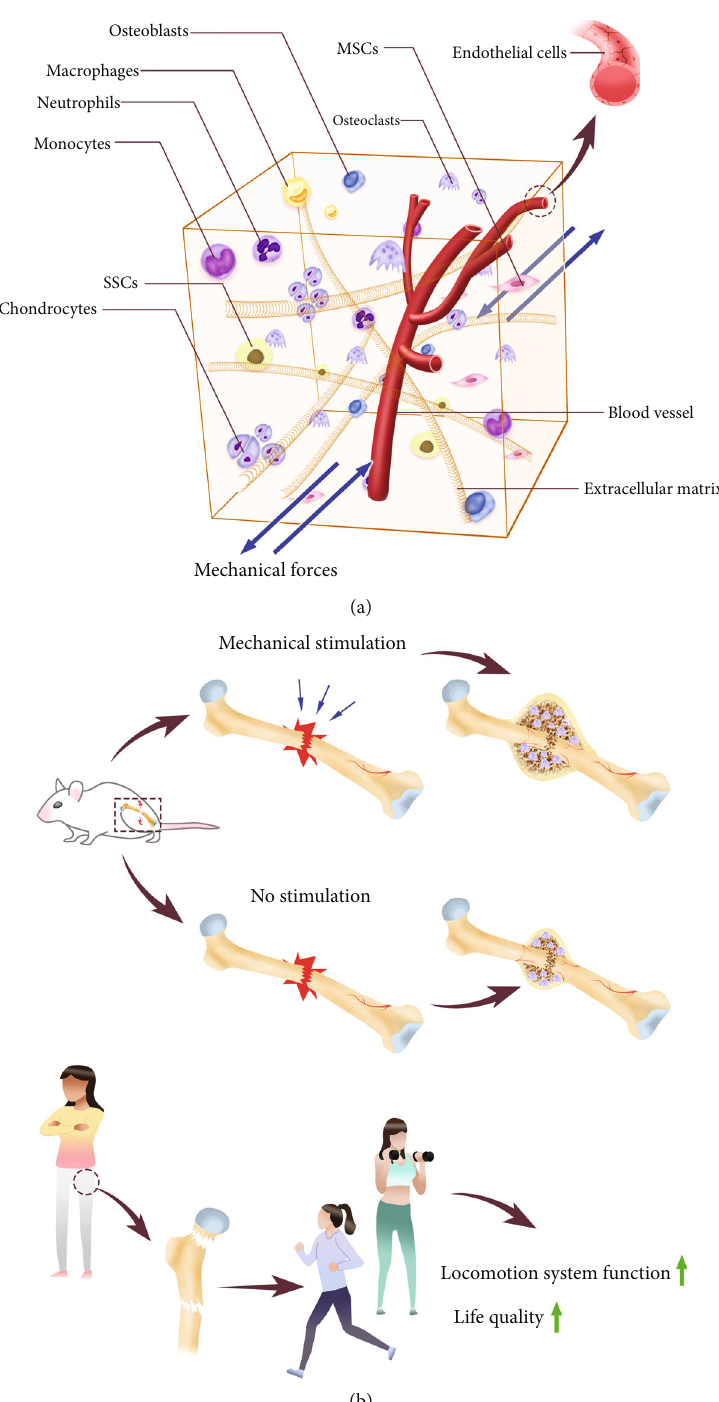
Figure 2: Mechanical stimulation and bone repair. (a) Cells and ECM in the bone tissue receive mechanical signals. (b) The e ff ects of mechanical stimulation and exercise on bone injury